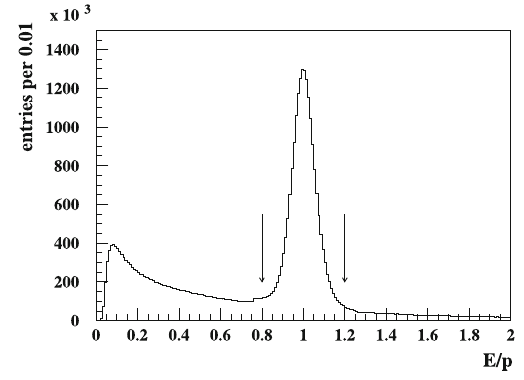
Fig. 3 E/p ratio for the real data 3. K + → π + π 0 with a “fake photon” and π + misidentified as a positron. The fake photon clusters can come from π n interaction in the gamma detector and from accidentals. 4. K + → π + π 0 γ when π + is mis-identified as a positron. 5. K + → π 0 π 0 e + ν when one γ is lost.